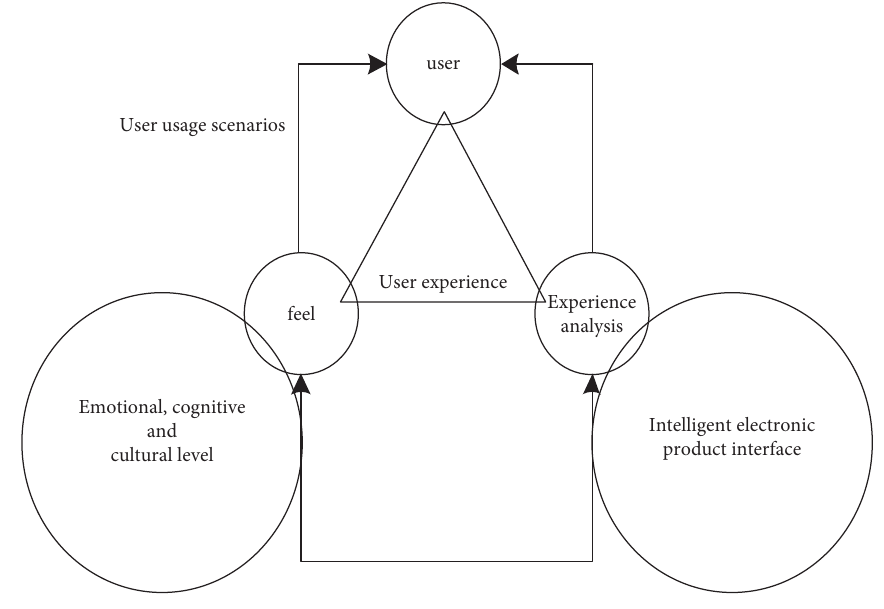
Figure 4: Experimental sample data collection mode.